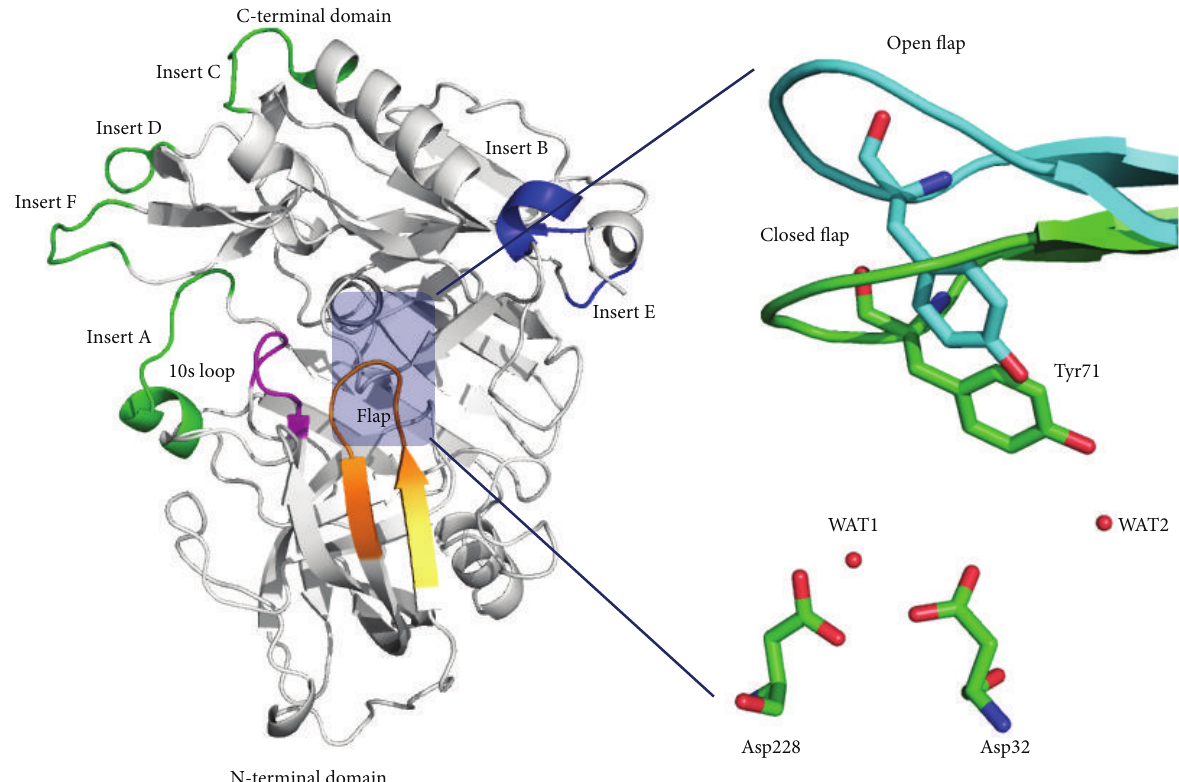
Figure 1: Critical regions of BACE1 that participate in the substrate recognition, catalytic Asp dyad, conserved waters (WAT1 and WAT2), and orientation of Tyr71 in open and closed conformation of the